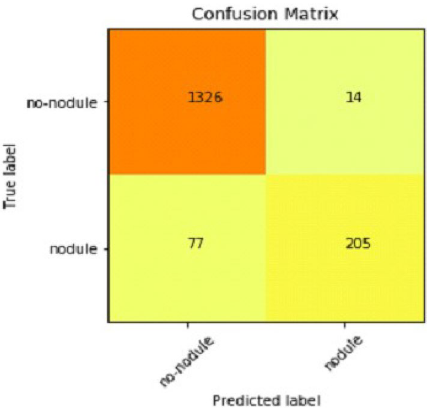
Figure 17. Confusion matrix of CNN 3.